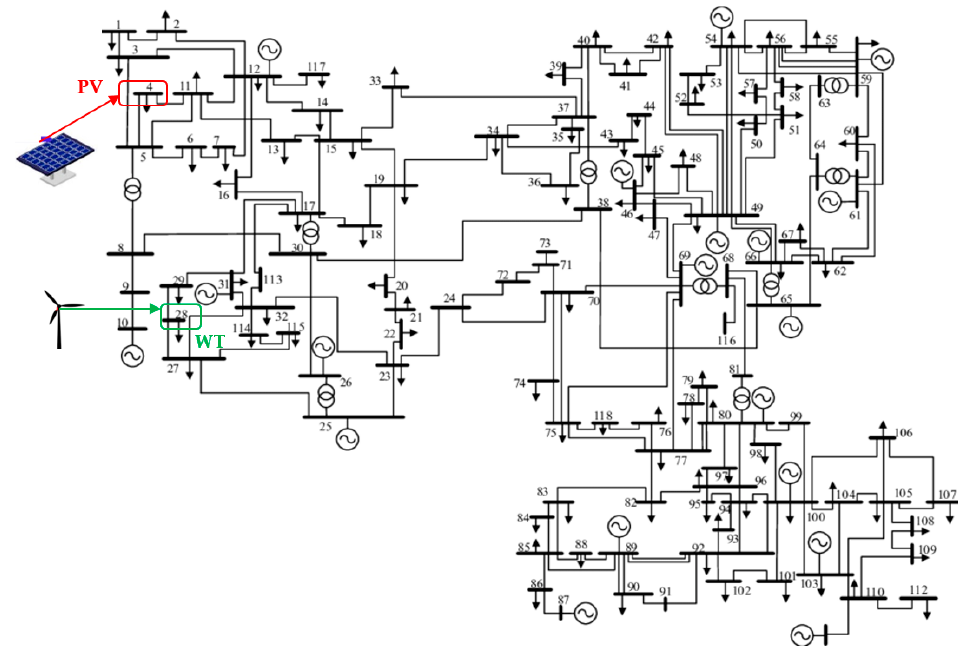
Figure A2. Single-line diagram of the IEEE 118-bus system.